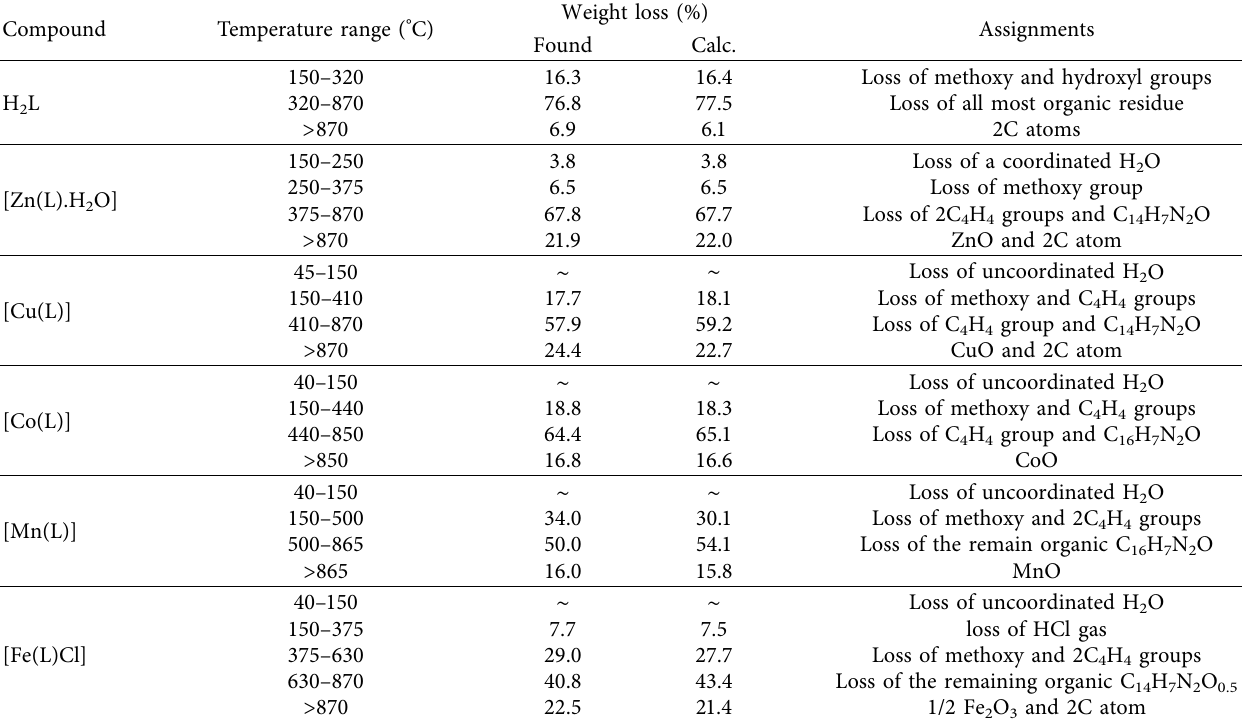
Table 3: TGA data of the ligand and its metal